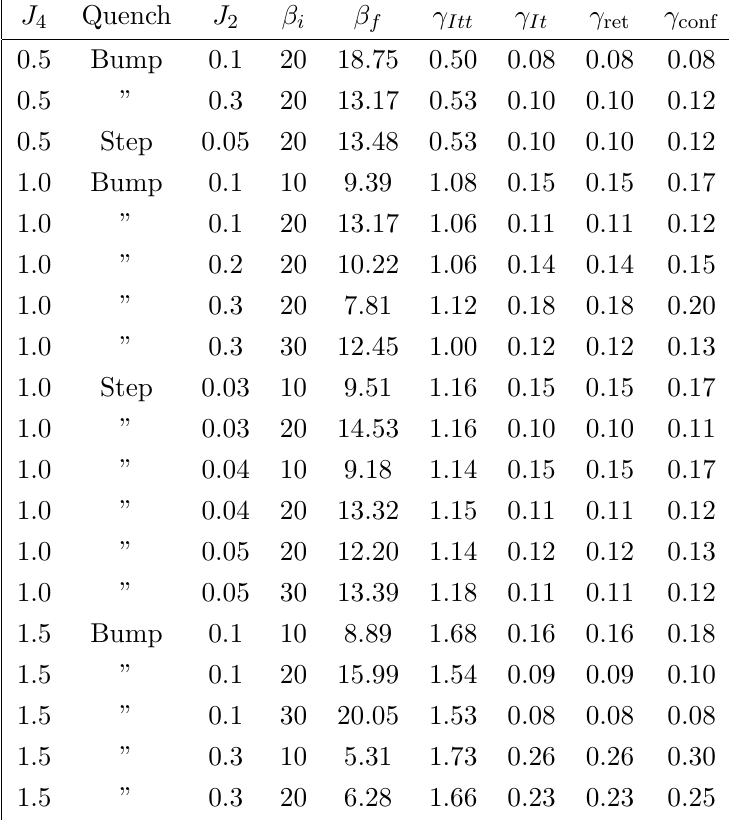
Table 1. Numerical results for di(cid:11)erent quench protocols in q = 4 theory by changing J 2 coupling. The following are absolute values after taking care of the time step dt = 0 : 05. The value of J 4 is (cid:12)xed during the entire quench process. The values of J 2 are the perturbations used to perform the di(cid:11)erent quench